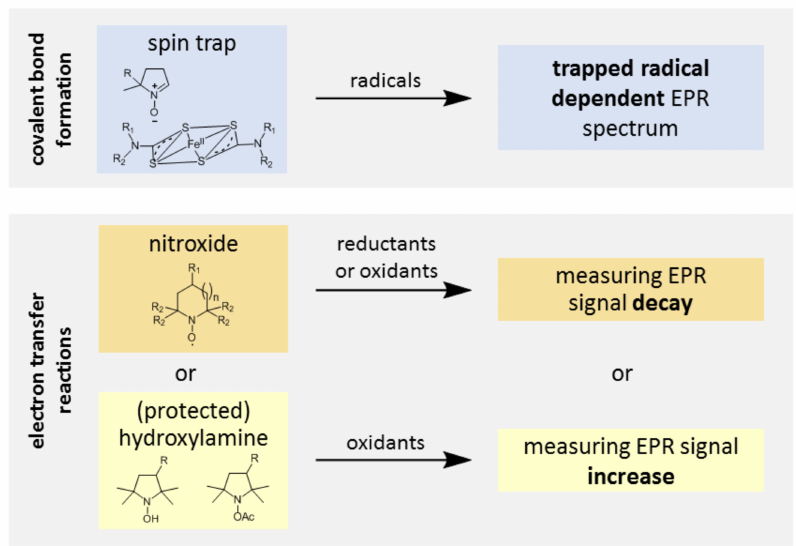
Figure 2. Principle of oxidative stress evaluation by EPR. Molecular probe administration is followed by monitoring of the EPR signal in vivo in a control vs. pathological